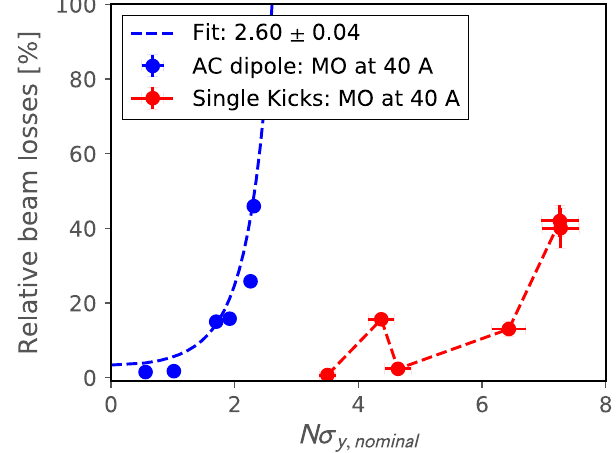
A.FIG. 12. Measured losses for ac dipole excitations (blue) and free kick (red) measurements with Landau octupoles powered at 40